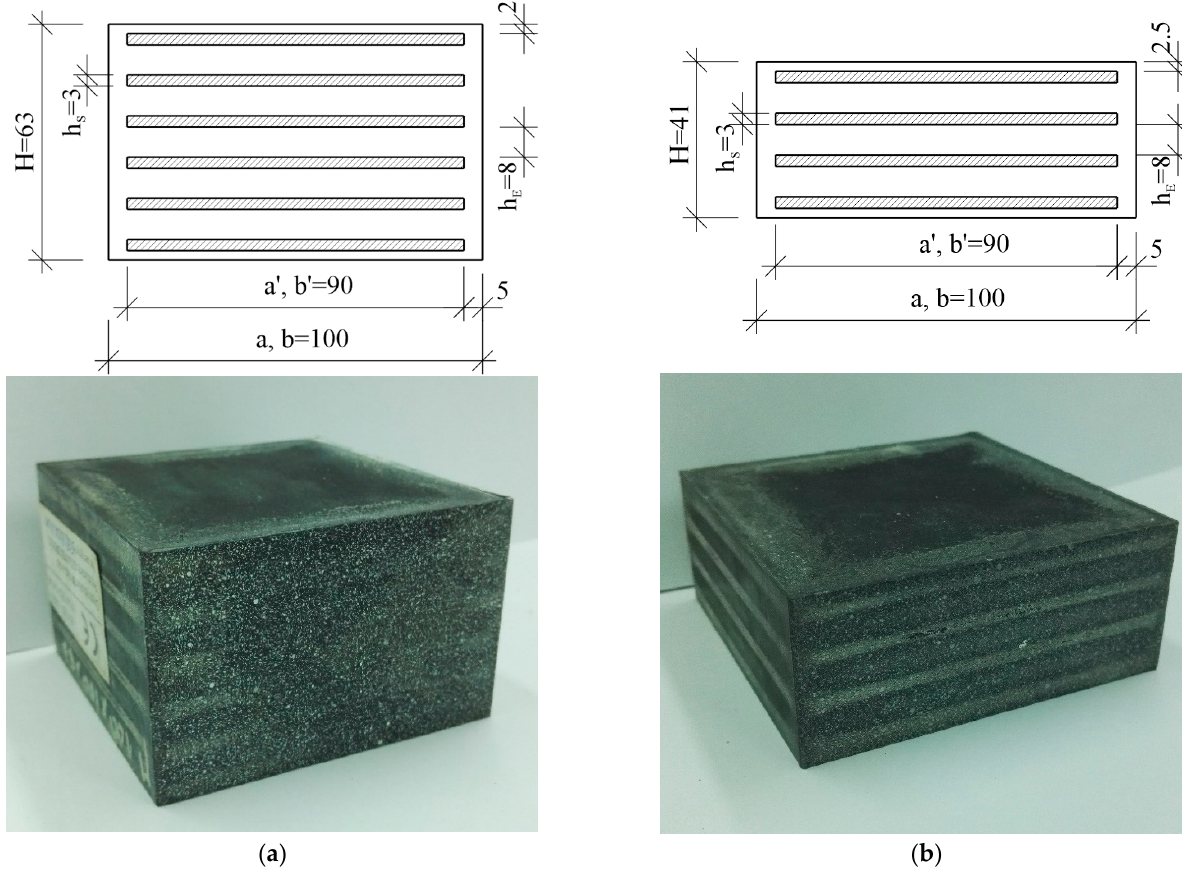
Figure 1. View of the considered bearings: ( a ) high bearing; ( b ) low bearing (dimensions in mm). Table 2. Geometry of elastomeric